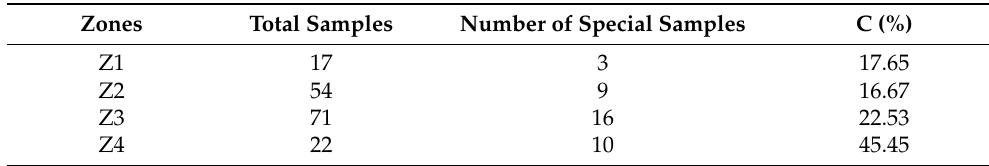
Table 2. The number of the special samples in four zones.